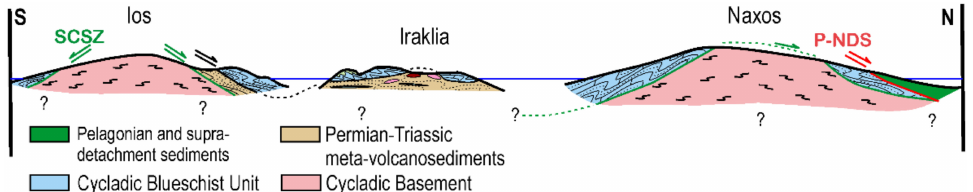
Figure 11. Simplified sketch illustrating the lithostratigraphic and structural correlations between Iraklia and the neighboring Ios and Naxos